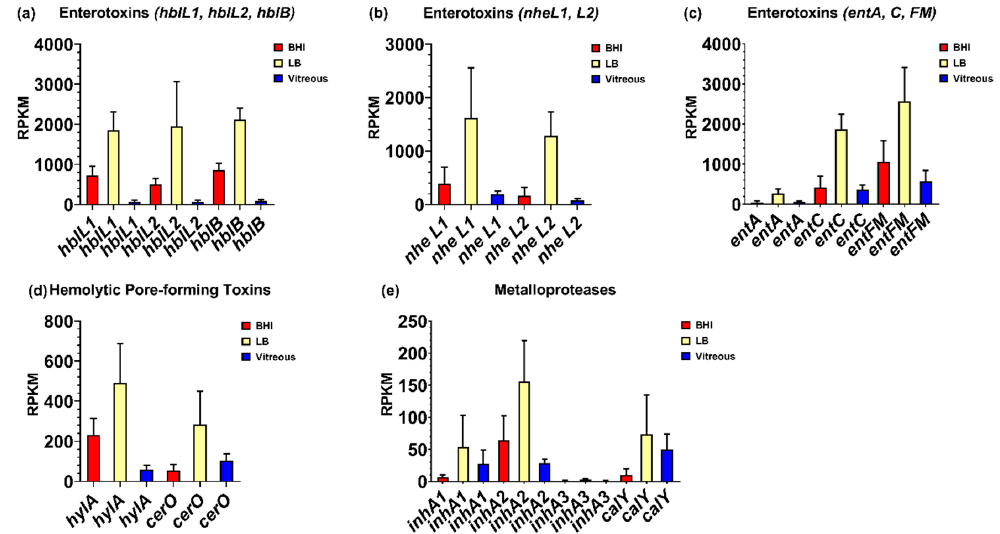
Figure 3 . Normalized virulence-related gene expression in each of the three different environments. Figure 3. Normalized virulence-related gene expression in each of the three di ff erent environments. Reads per kilobase per million (RPKM) for the genes specifying hemolysin BL (Hbl) ( a ),